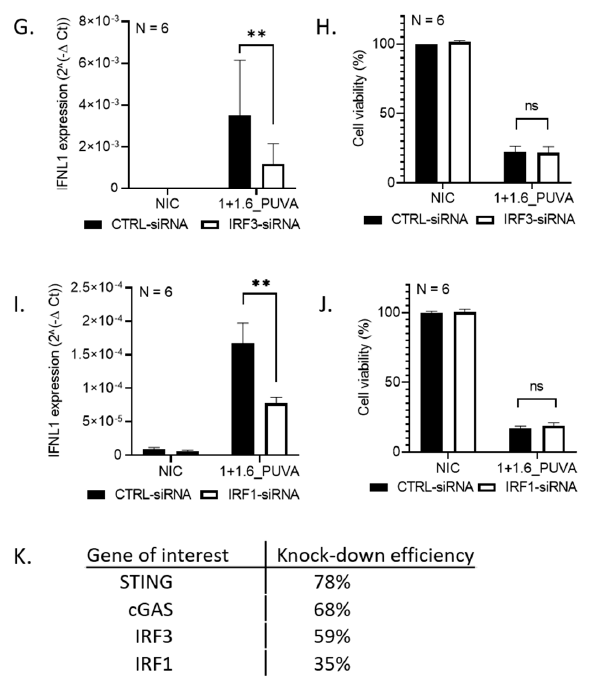
Figure 3. The Stimulator of Interferon Genes (STING) pathway is activated in Hut78 by 8–MOP + UVA treatment. Downregulation of alleged pathway elements by specific small interfering RNA (siRNA) or by a chemical inhibitor result in decreased IFNL1 expression. Expression of IFNL1 following 8–MOP + UVA treatment combined with ( A ) STING downregulation by siRNA, ( B ) cyclic GMP-AMP synthase (cGAS) downregulation by siRNA, ( C ) TBK1 inhibition by BX795 chemical inhibitor, ( D ) IRF3 downregulation by siRNA and ( E ) IRF1 downregulation by siRNA. Cell viability for respective treatments is presented in ( F ) for STING-siRNA, ( G ) for cGAS-siRNA, ( H ) for BX795-mediated TBK1 inhibition, ( I ) for IRF3-siRNA and ( J ) for IRF1-siRNA. ( K ) Transfection e ffi ciencies for various siRNAs. Error bars represent ± SEM of the indicated N repeats. Statistics—normal distribution, paired t -test: ( A – E ) and skewed distribution, paired Wilcoxon: ( F –J). Choice of the statistical test was made based on the type of data distribution (see Methods). * p < 0.1, ** p < 0.05, ns–not